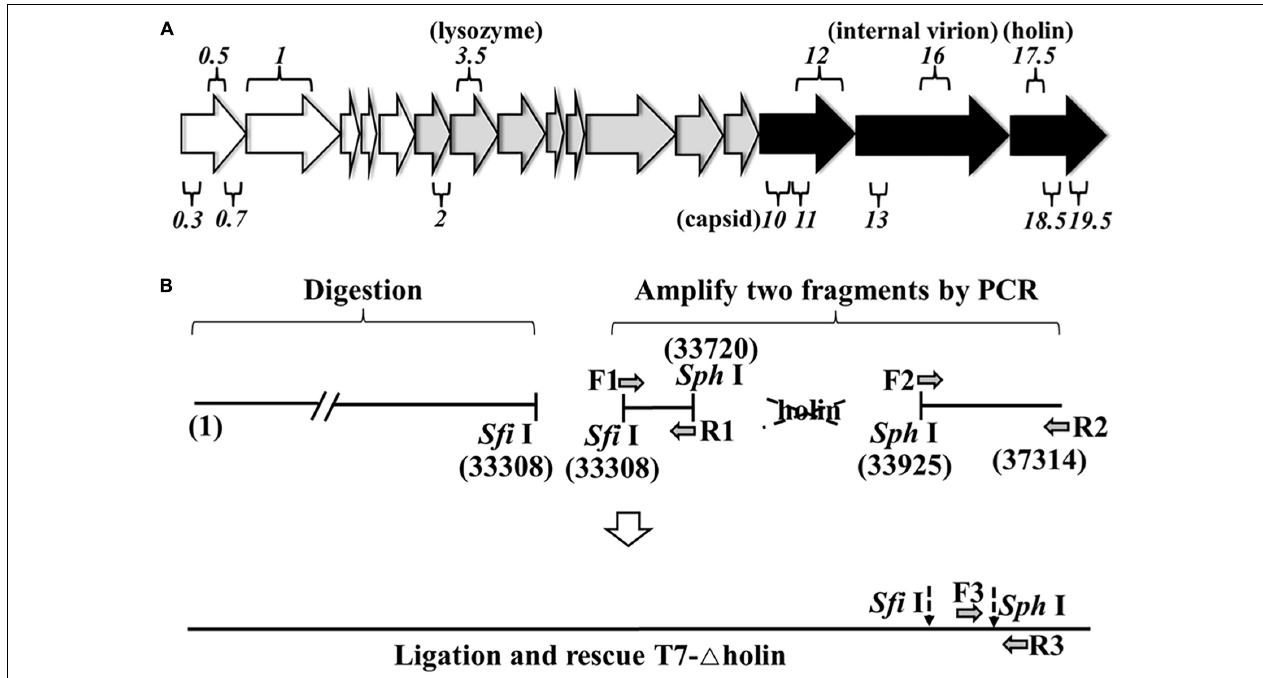
FIGURE 1 | Rescue of T7- (cid:52) holin mutant phage. (A) Major transcripts from bacteriophage T7 genome. Empty arrows on the left represent early genes, gray arrows in the middle represent intermediate genes, and black arrows on the right represent late genes. Among the 56 known or potential genes, only a selected subset of genes mentioned in the text is shown. The numbers over and under the arrows indicate gene designation. (B) Strategy used to rescue a holin gene deletion mutant phage. The number in bracket stands for the gene position. The dotted arrows indicate the restriction enzyme sites.